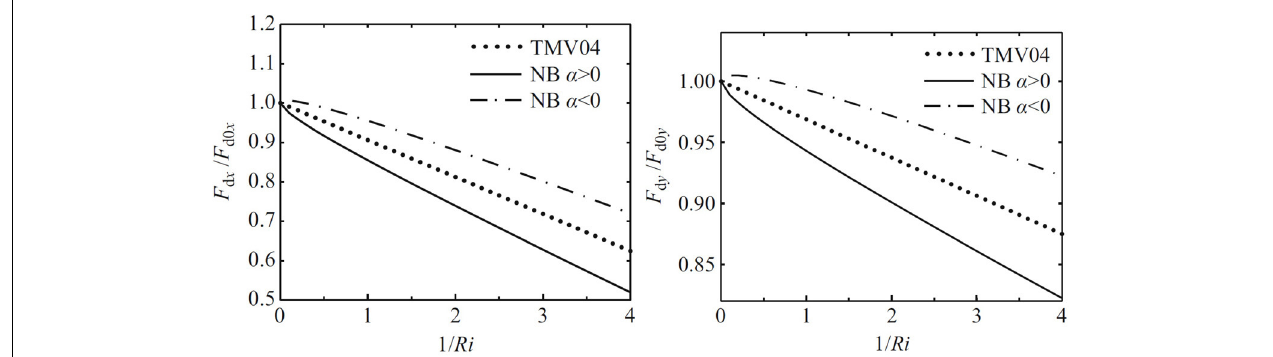
see legend), and the dotted line is the original Boussinesq result (46). Reproduced from Figure 1 of Tang et al. [69] with kind permission from Springer Science and Business